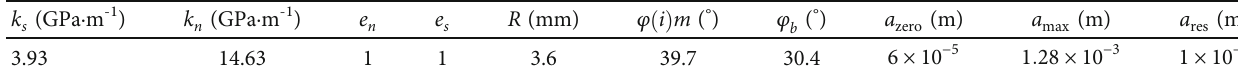
Table 4: Mechanical parameters of C-Y model.